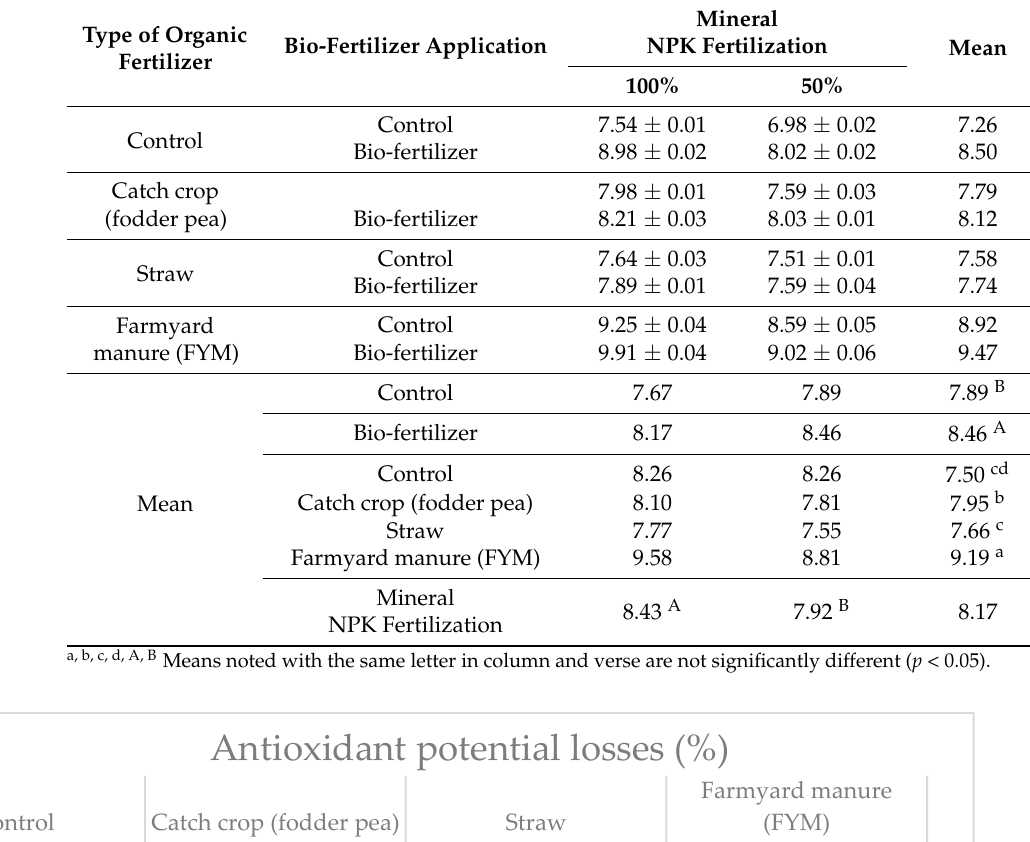
Table 9. Antioxidant capacity (FRAP) in potato tubers after harvest depending on the applied research factors (mmol Fe 2+ · kg − 1 ) (mean from 3 years).